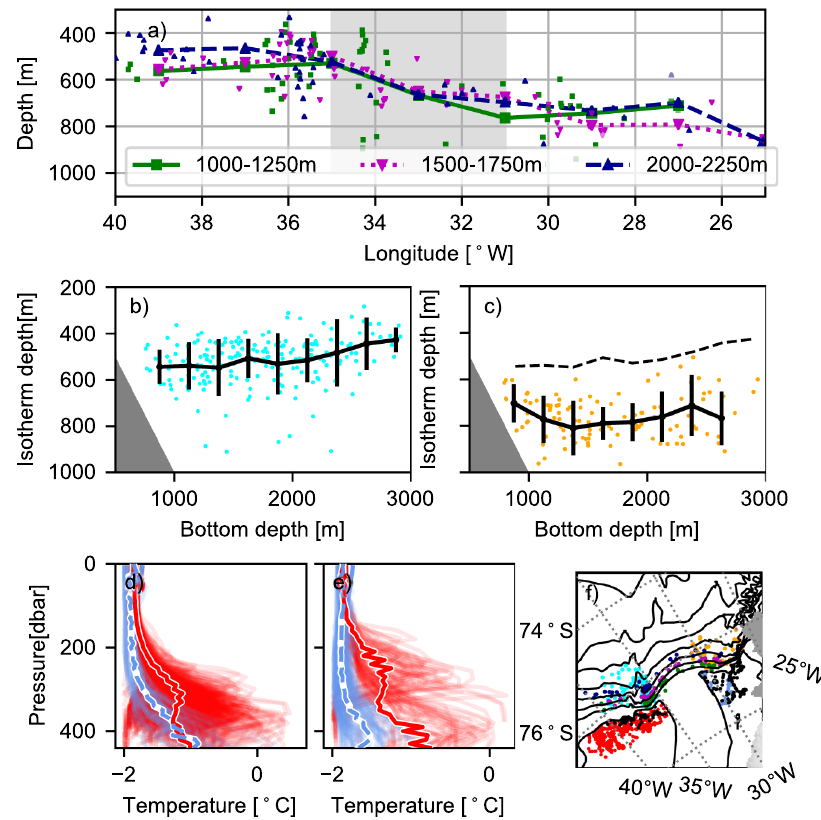
Fig.3|Thermoclinedepthabovetheslopeandontheshelf.a Depthofthe0.5°C isotherm from all available temperature pro fi les as a function of longitude in bot- tomdepthrangesaccordingtothelegend.Thesmallmarkersindicateanindividual pro fi le, and the lines show the mean value in 2-degree longitude intervals. The position of the pro fi les is indicated (in the corresponding color) in f . The gray shading indicates the longitudinal range of the Filchner Trough (FT). Depth of the 0.5°Cisothermasafunctionofbottomdepth b westand c eastoftheFT.Theblack